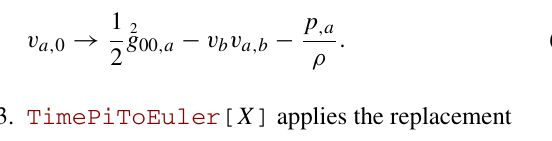
Table 3 Functions to transform specific PPN potentials Function